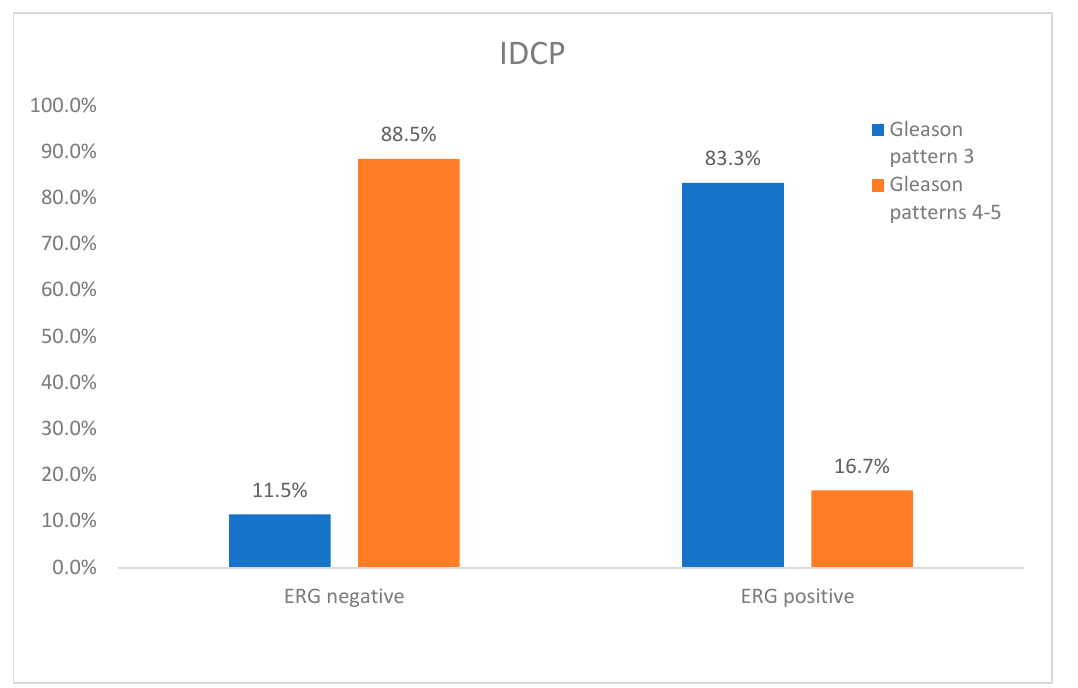
2775 Figure 7. PTEN positivity in HGPIN (left side of the image) with concomitant PTEN positivity in adjacent low-grade invasive carcinoma (arrows showing PTEN positive focus of HGPIN and inva- sive glands). Simultaneous ERG nuclear expression in both HGPIN and invasive cancer (×200). 3.4. ERG Expression in IDCP and Its Association with the Adjacent Invasive Prostate Carci- noma In IDCP, the Gleason grade pattern of the adjacent invasive component showed statisti-